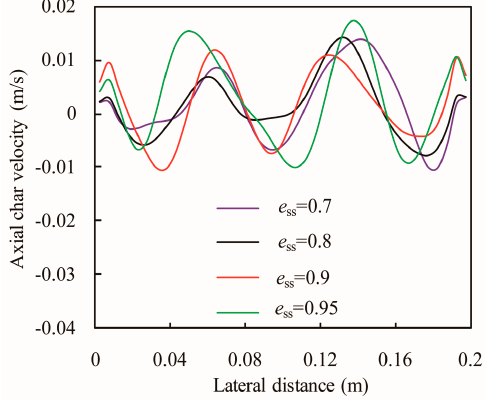
Figure 4. Lateral profiles of the time-averaged axial velocity of the flotsam at Z = 0.153 m.